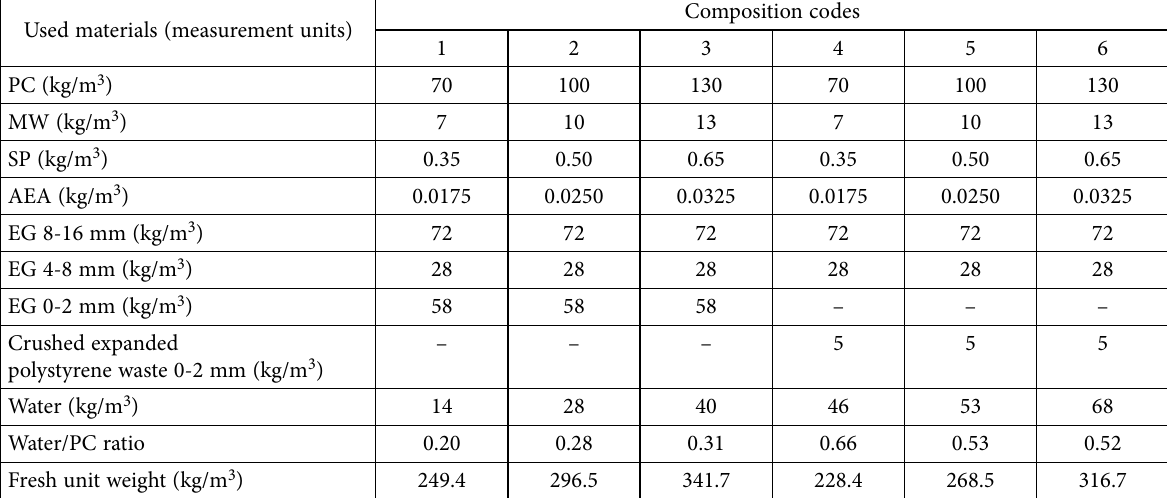
Table 2. Compositions of forming mixtures of LWAC specimens Used materials (measurement